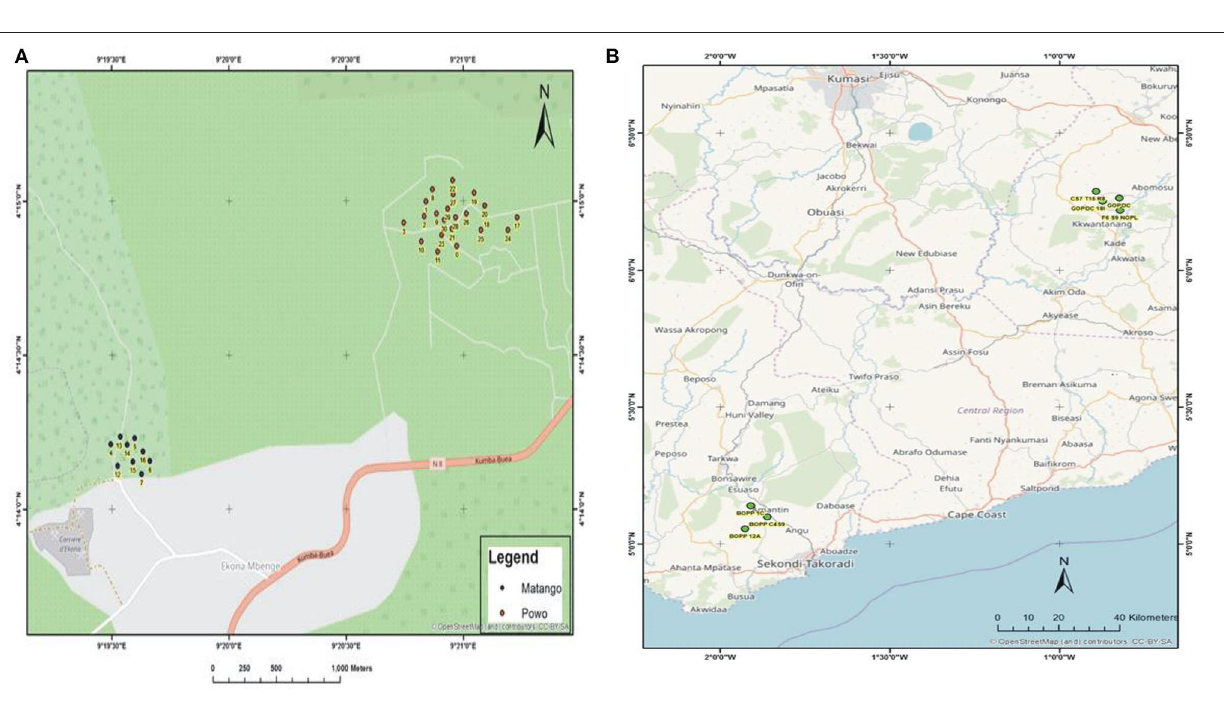
of F. oxysporum (1) from Cameroon; F. oxysporum (4) from Cameroon; F. oxysporum (CRT) from Ghana, and F. oxysporum (13) from Nigeria were selected for further studies based on